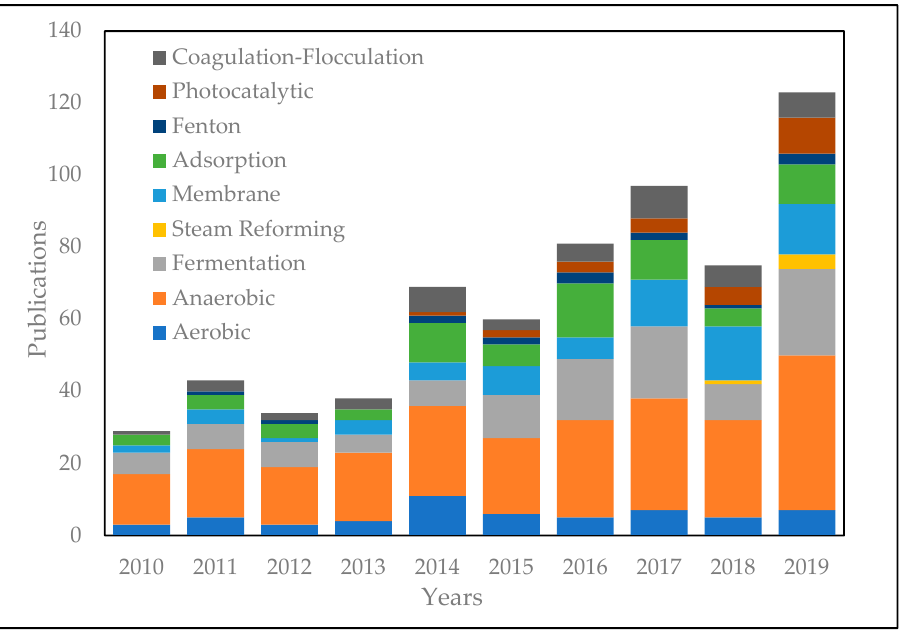
Figure 3. The number of annual publications related to POME treatment technologies in the past ten years. Indexed by Scopus (TITLE-ABS-KEY (terms); terms: aerobic, anaerobic, fermentation, steam reforming, membrane, adsorption, Fenton, photocatalytic, ozonation, and coagulation-flocculation for palm oil mill effluent).